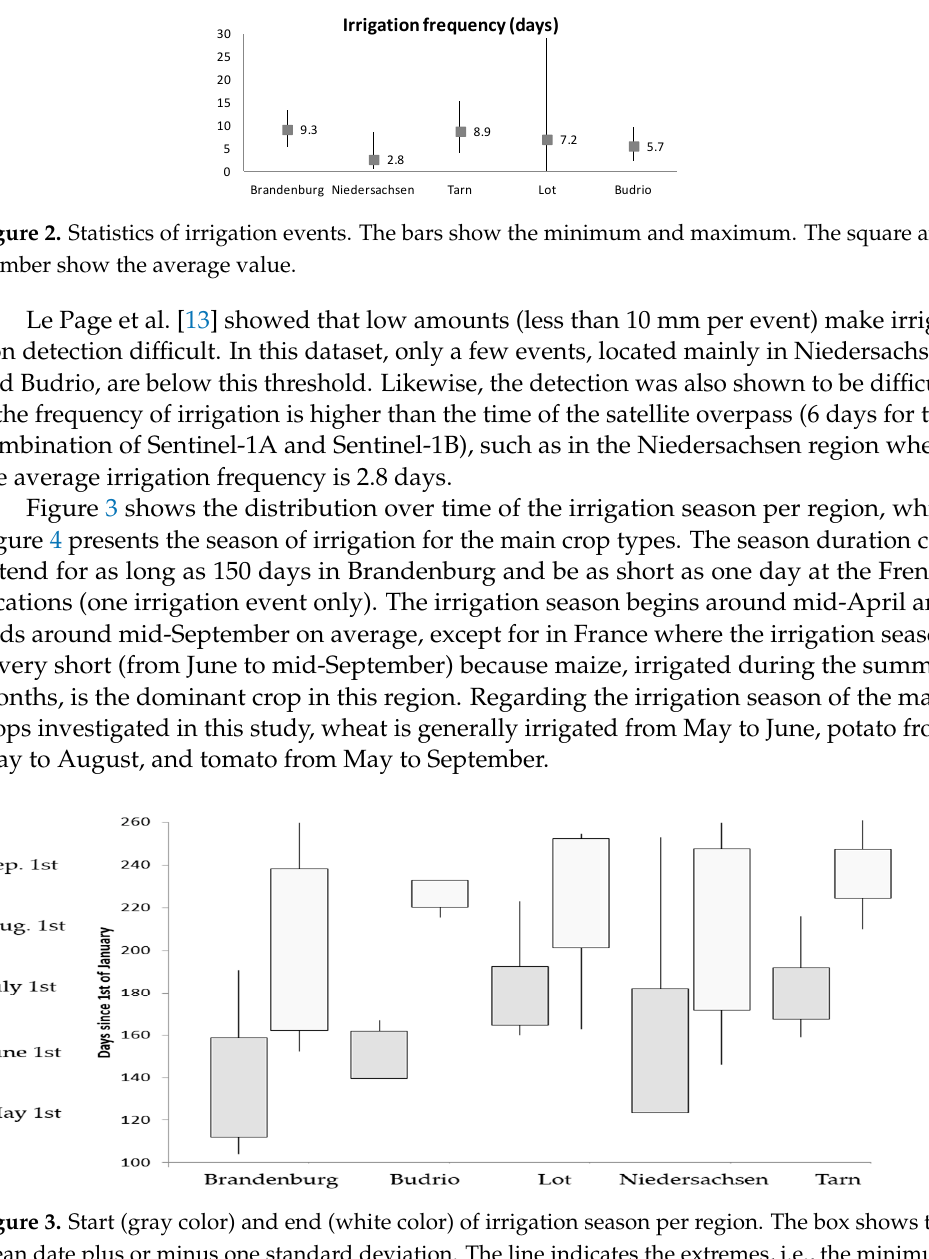
Figure 3. Start (gray color) and end (white color) of irrigation season per region. The box shows the mean date plus or minus one standard deviation. The line indicates the extremes, i.e., the minimum and maximum date of beginning and end of the irrigation season.